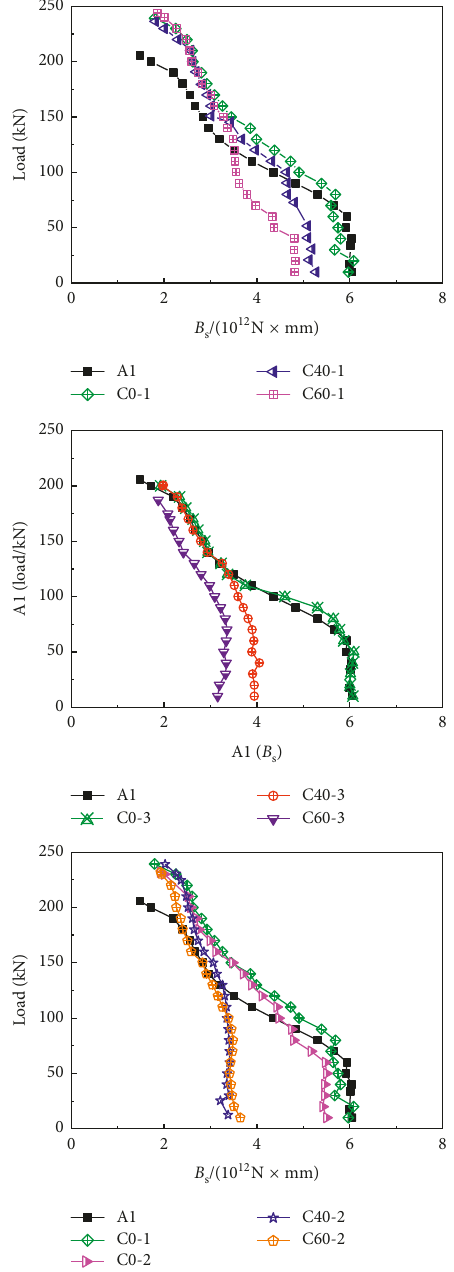
Figure 9: Flexural